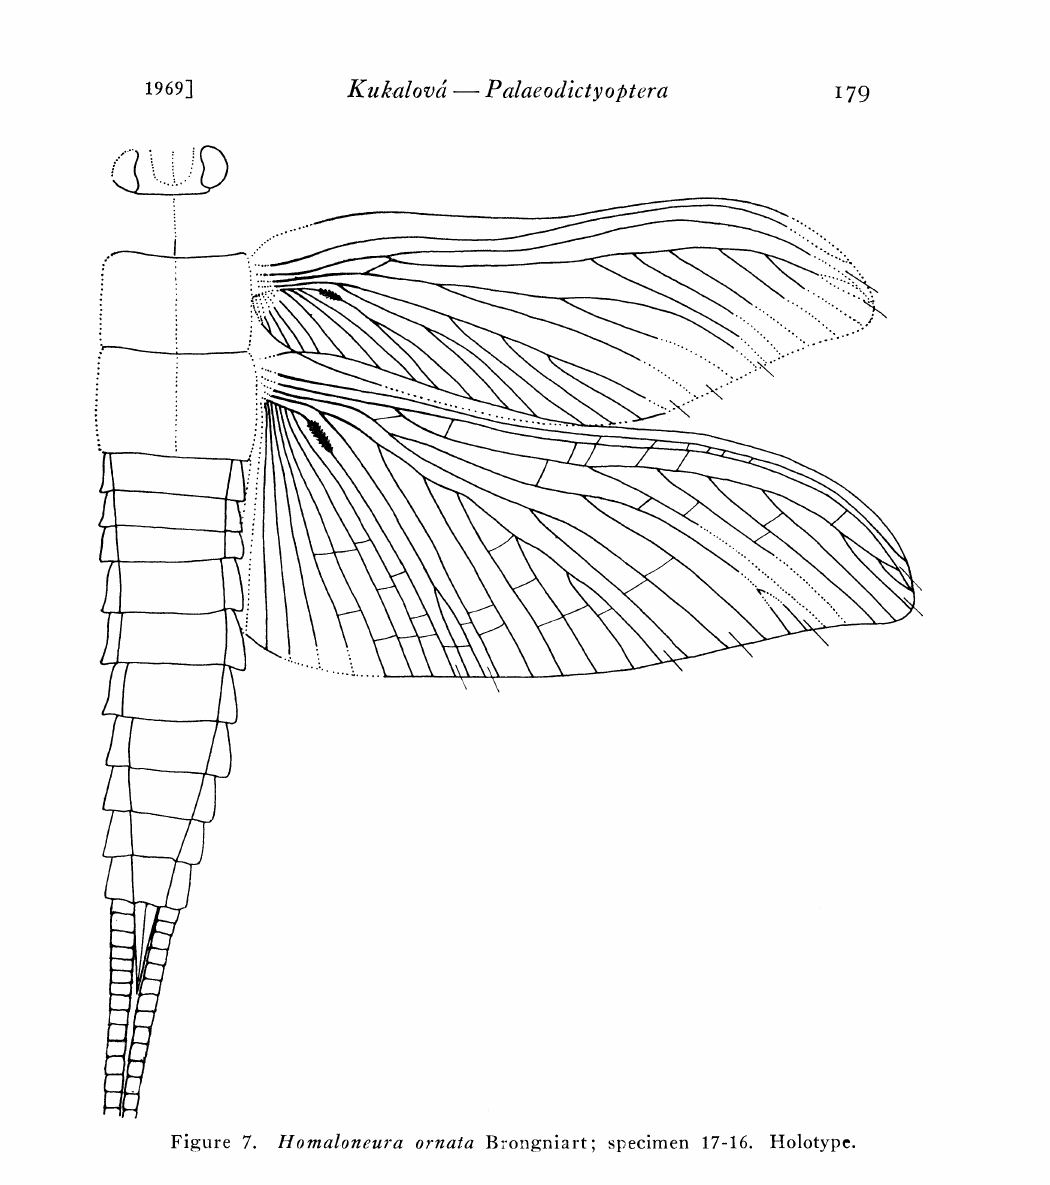
Figure 7. Homaloneura ornata Brongniart" specimen 17-16.